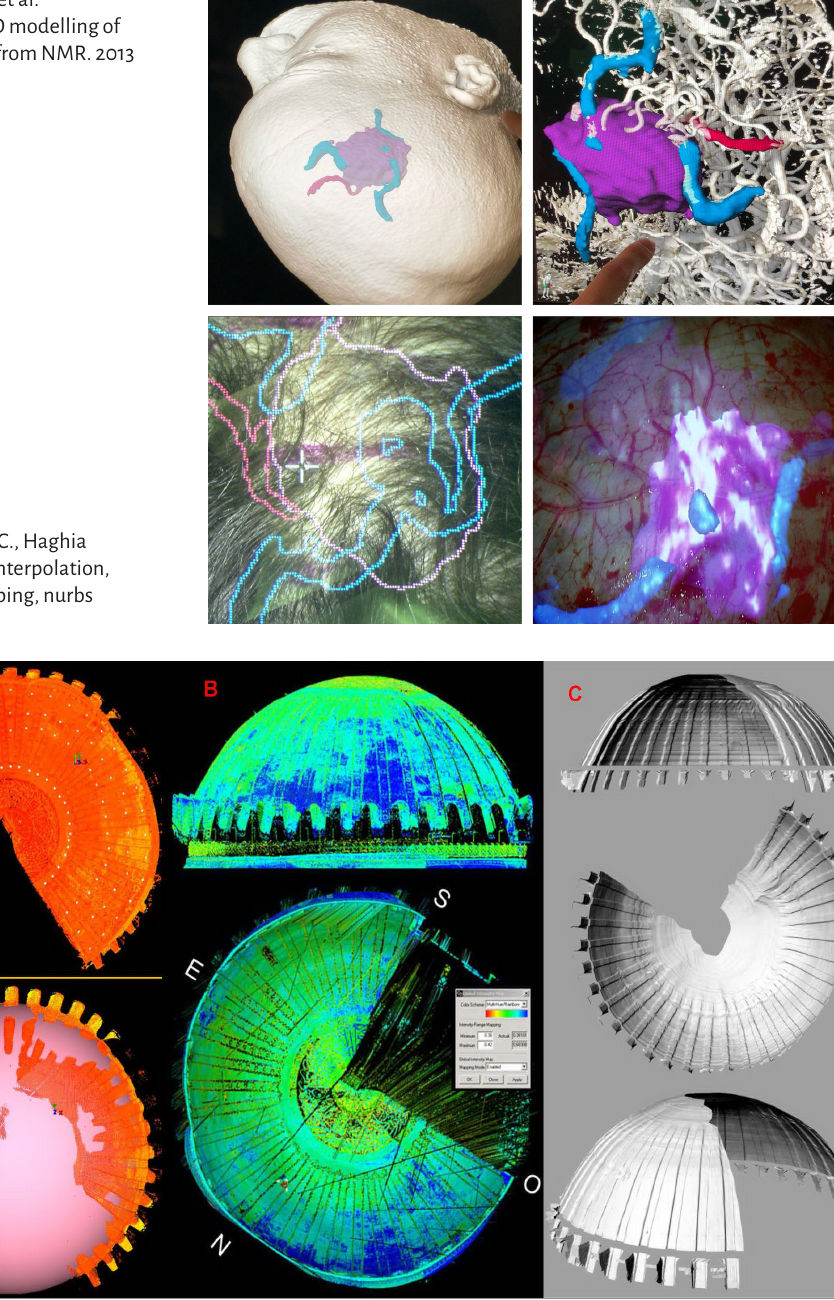
Fig. 12 Martino J et al. Neurosurgery, 3D modelling of brain structures from NMR. 2013